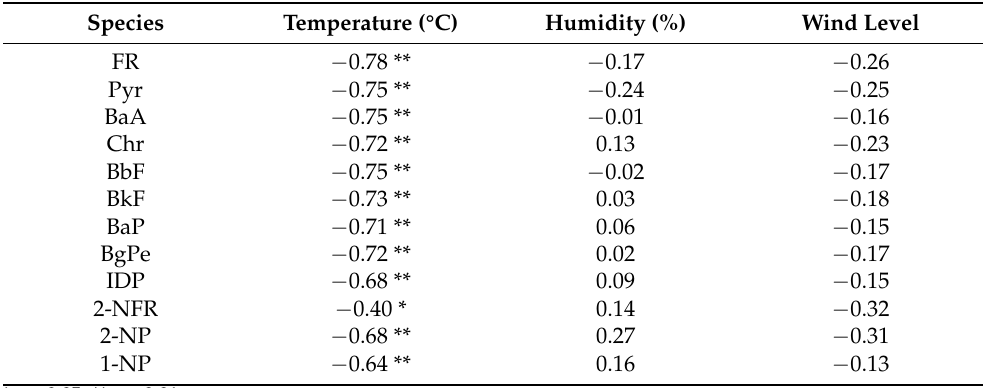
Table 2. Correlations among the individual PAHs and NPAHs with meteorological conditions in PM 2.5 during the sampling periods ( n =